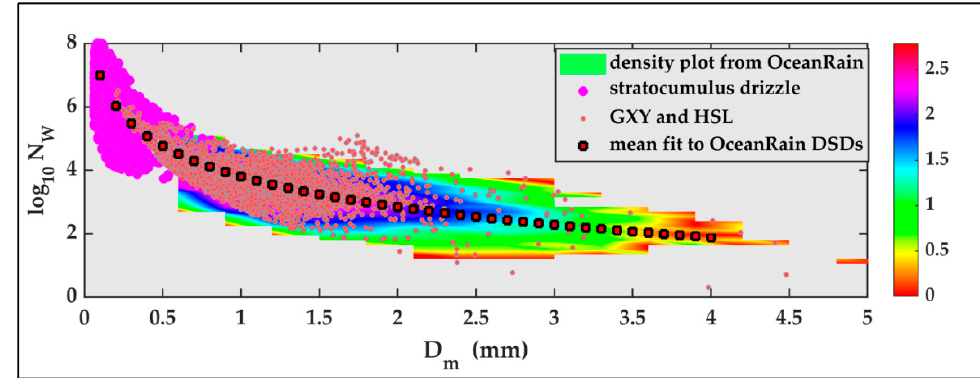
Figure 5. Scatterplot of log 10 (N W ) versus D m from three regimes described in the legend. The contoured density plot (refer to color bar) is from OceanRain. The mean fit to OceanRain is N W = 6383.8 D m − 3.19 , where N W is in mm − 1 m − 3 shown as red-filled black squares. The GXY- and HSV-based points are shown in light red and those from stratocumulus DSDs are shown in magenta.